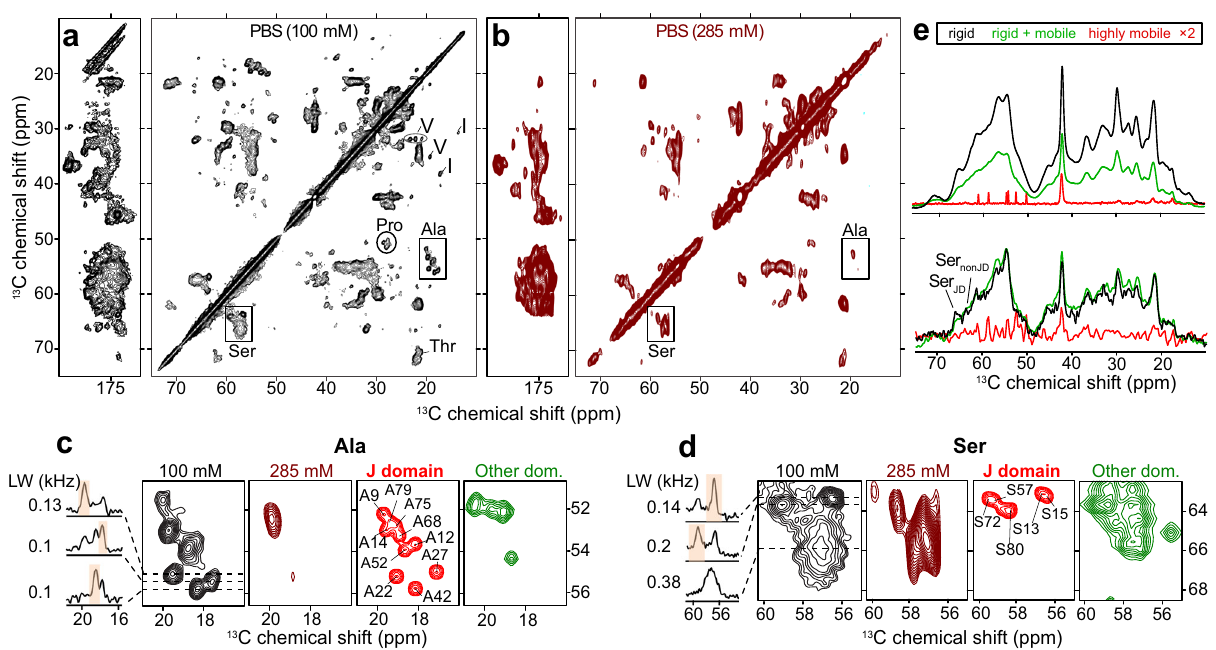
Fig. 3 Solid-state NMR of DnaJB8 oligomers at physiological and high ionic strength. a 2D 13 C- 13 C ssNMR spectrum of U- 13 C, 15 N-labeled DnaJB8 oligomers in PBS (100 mM NaCl), using 25 ms DARR mixing. b Corresponding 2D ssNMR spectrum in PBS with 285 mM NaCl. c , d Boxed Ala and Ser regions from panels ( a and b ). In PBS, the experimental Ala and Ser peak patterns (black) are well resolved and similar to those expected for folded JD in solution (red). At elevated ionic strength (brown) these narrow peaks are missing. Green spectra (right) represent simulated signals predicted for our models of the non-JD domains, shown with enhanced broadening re fl ecting the heterogeneity seen in the experiments. 1D spectra on far left show slices through the experimental 2D data, with selected peak widths (in kHz). e 13 C 1D spectra, in PBS (top) and with 285 mM NaCl (bottom), that show rigid residues (black, CP), rigid and mobile residues (green, SPE), and only mobile residues (red, INEPT). See also text and Supplementary Fig.